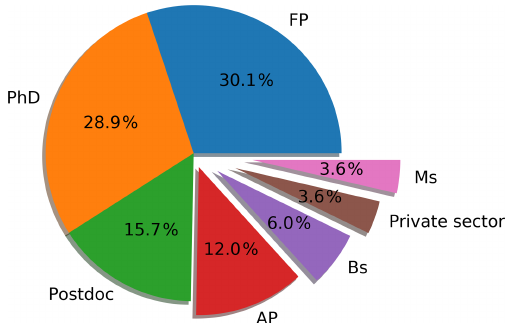
Figure 2. Career level of the authors of the accepted testimonies. FP stands for full professor, PhD for PhD student, Postdoc for postdoc- toral fellow, AP for assistant or associate professor, Bs for bachelor student, Private sector for contributors working outside academia and Ms for master